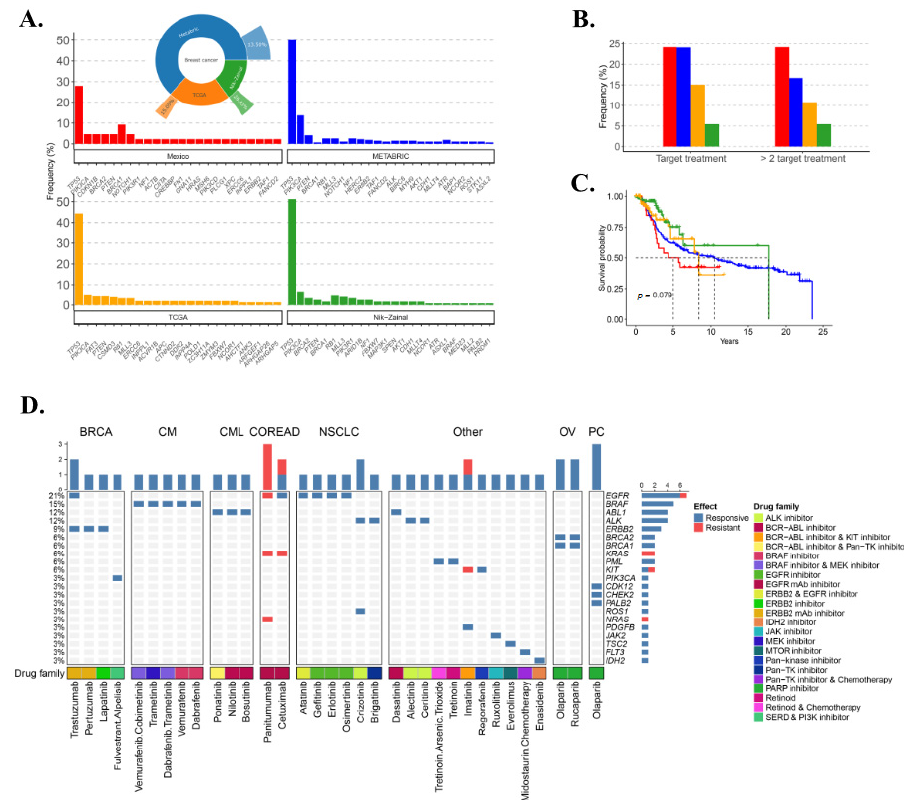
Figure 6. Distribution of target treatments in the Mexican cohort, METABRIC, TCGA, and Nik–Zainal TNBC. ( A ) Frequency of the top 24 genes mutated for every cohort. Inset: Frequency of TNBC cases